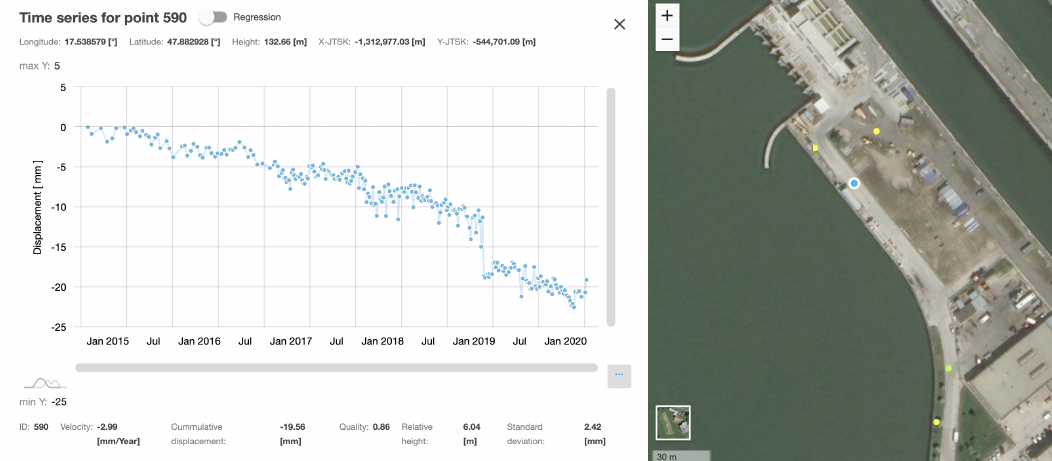
Figure 19. Displacement time-series shown for point over Gabcikovo